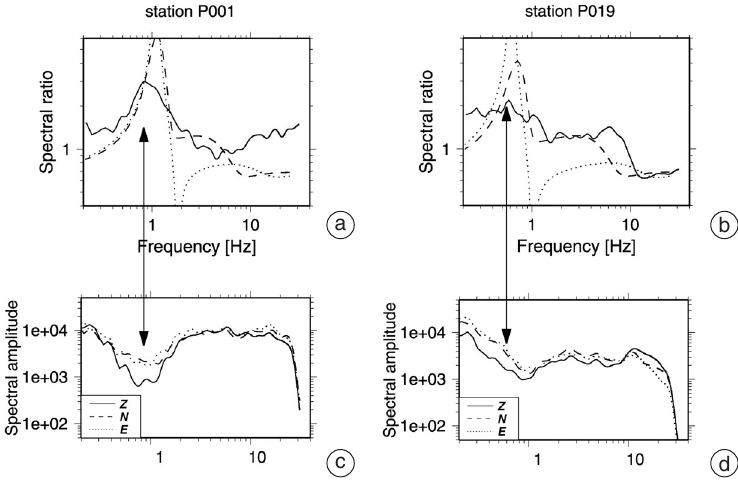
Fig. 7a-d. Measured H / V ratio (solid line) and theoretical ellipticities for station P001 (a) and P019 (b). The el- lipticities were determined for the power-law model (dashed line) of Hinzen et al. (2003) and a three-layer over halfspace model (dotted line) after Kind (2002). Model parameters are found in table II. Additionally, the indi- vidual component spectra ( E , N , Z ) for both stations are plotted (c and d). The vertical arrows point to the H/V peak frequencies in panels (a) and (b) and relate those to the individual component spectra in panels (c) and